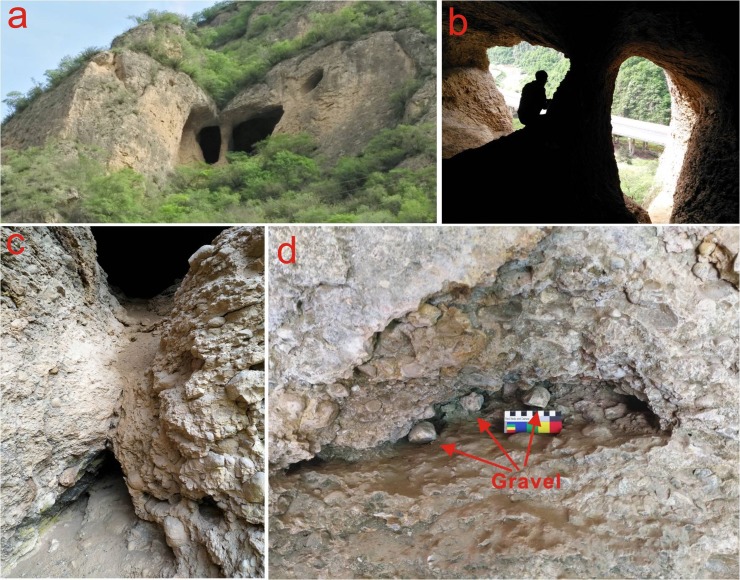
Geomorphic features of Hudiedong Cave.(a) External features of Hudiedong Cave, (b) view of the exterior from inside the cave, (c) water drainage channel, and (d) gravel exfoliation.